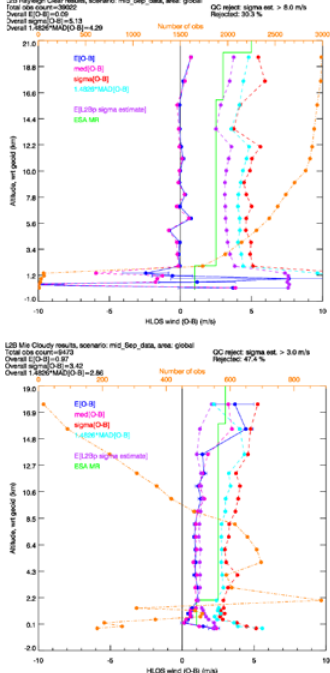
Figure 3: Aeolus Rayleigh (molecular return, top panel) and Mie (particle return, lower panel) wind observation monitoring statistics, 15 September 2018 (M. Rennie). Green: observation random error requirement, Blue: mean (observation (o) – ECMWF model background (b)), Red: (cid:2) (o – b), Pink: median value (o – b), Magenta: scaled medium absolute deviation (o - b), Purple: L2B processor estimated random